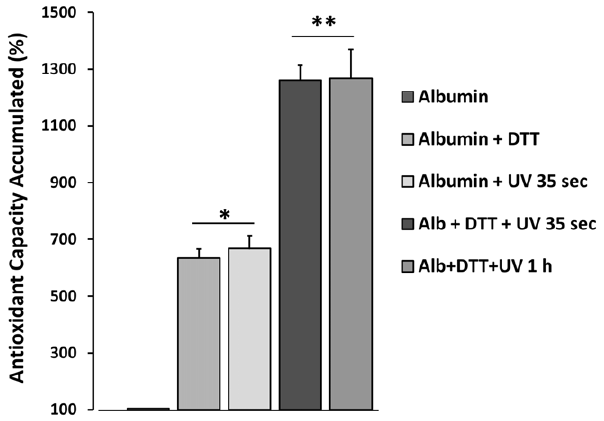
Figure 5. Contribution of thiol groups to the albumin antioxidant Response Surplus (RS) component. Reduced albumin and albumin exposed 35 seconds to UV light (254 nm) presented equivalent changes in antioxidant capacity (ACA% around 600%). However, when samples reduced previously with DTT were exposed to UV light for 35 seconds, it was possible to observe an additive effect (ACA% around 1300%). Additional exposure time to UV light does not produce additional antioxidant changes. Results are expressed as mean 6 SD (n=5). * p , 0.005 vs. native albumin; ** p , 0.001 vs. albumin + DTT and albumin + UV light 35 sec.